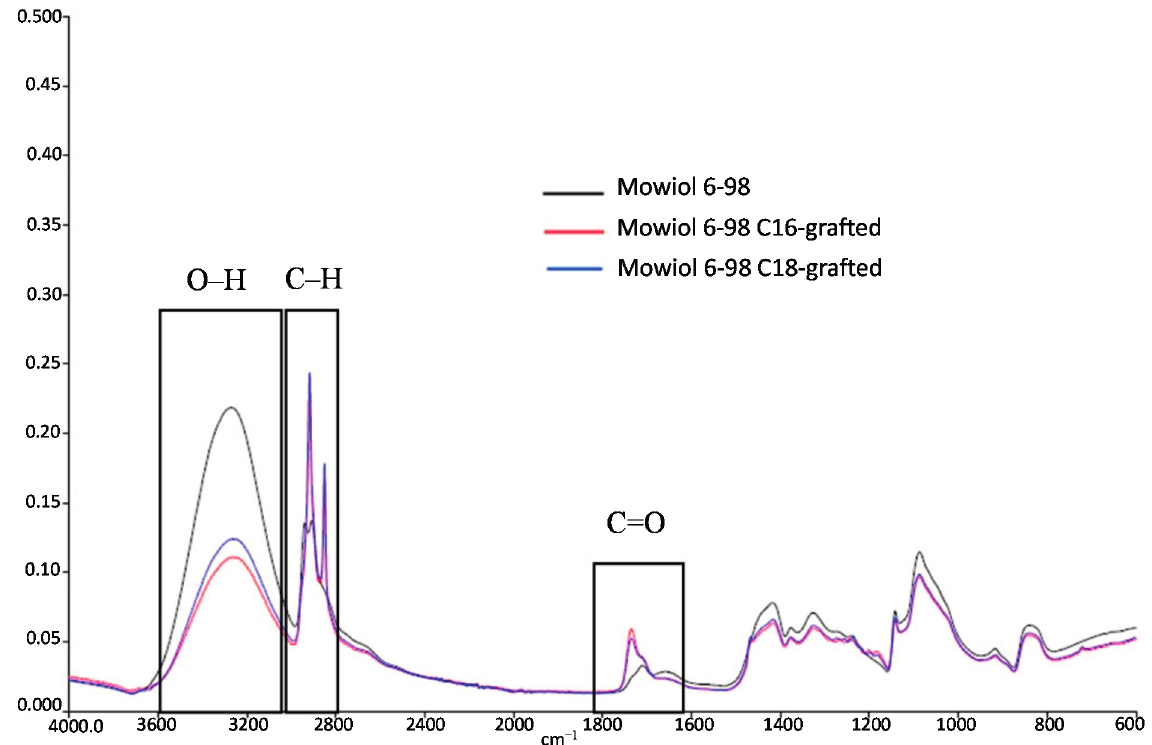
Figure 7. ATR-FTIR absorbance spectrum of SCC (sized coated and calendared paper) paper coated with Mowiol 6-98: before (black) and after chemical grafting (C16 in red; C18 in blue); the wavenumber ranges for characteristic functional groups are indicated along with their chemical